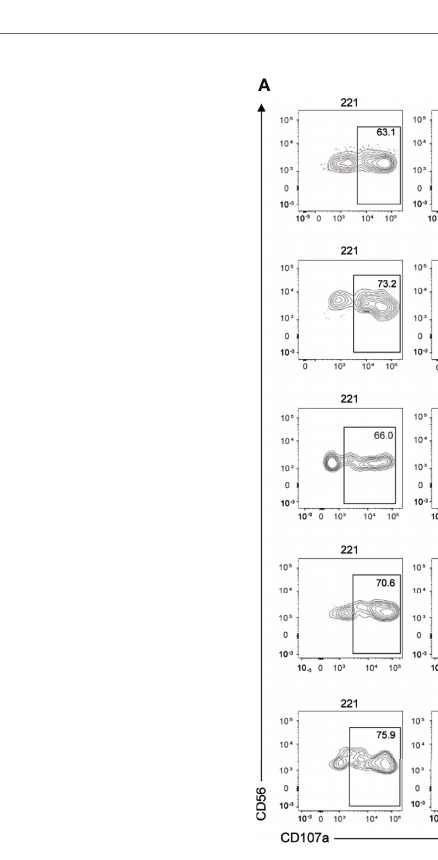
FIGURE 5 | Inhibition of ERAP1 enhanced NK cell killing of 221-B*51:01 cells by affecting the engagement of NKG2A. (A) , Example of degranulation by human CD56 + NK cells from one healthy donor; CD107a cell surface expression was measured in NKG2A positive subset negative for KIR3DL1, KIR2DL1 and KIR2DL3 in response to ERAP1-inhibited 221 transfectants and control cells. The percentage of CD107a + cells within the indicated NK cell subset is shown. (B) , Summary of NK cell degranulation in the NKG2A positive KIR negative NK subset from healthy donors after stimulation with 221 parental and transfectant cells in response to ERAP1 inhibition. P values, calculated by two-tailed paired Student ’ s t -test. ns, not signi fi